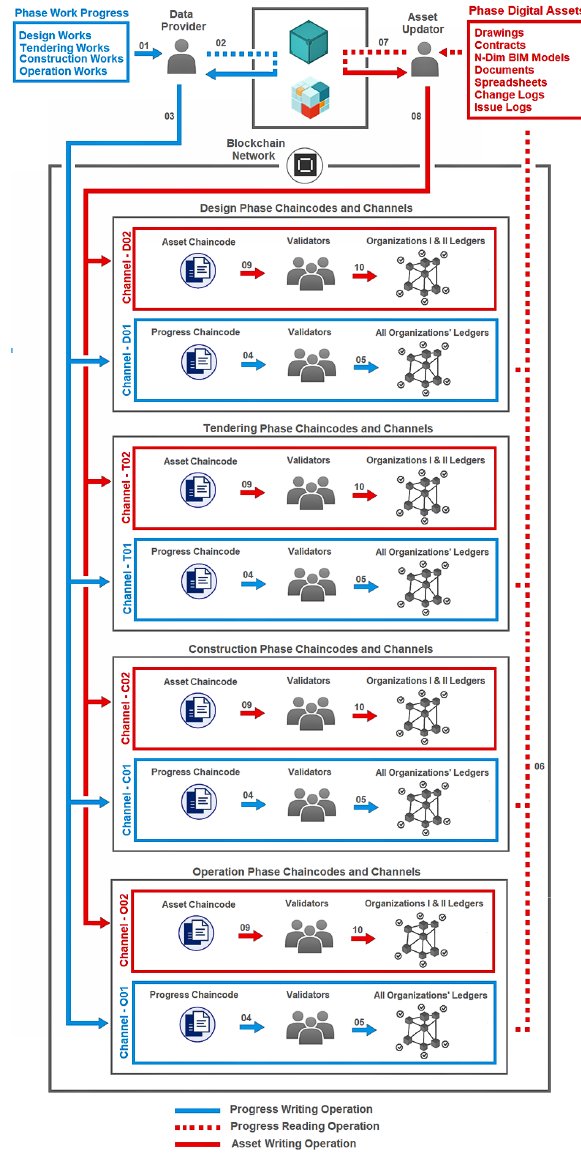
Figure 8. Application of the system in various work